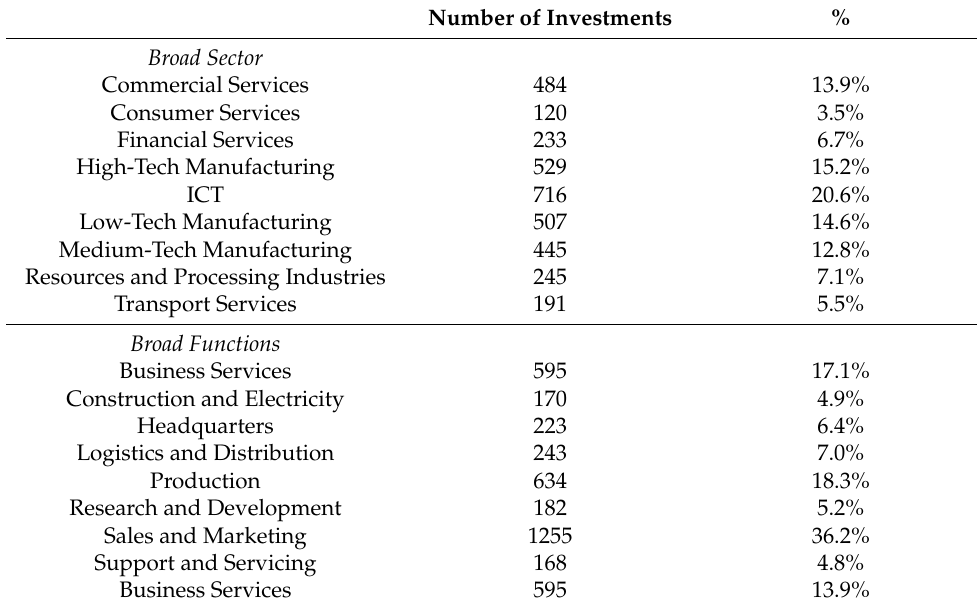
Table 1. Distribution of Greenfield FDI across Broad Sectors and Functions (2003–2010).